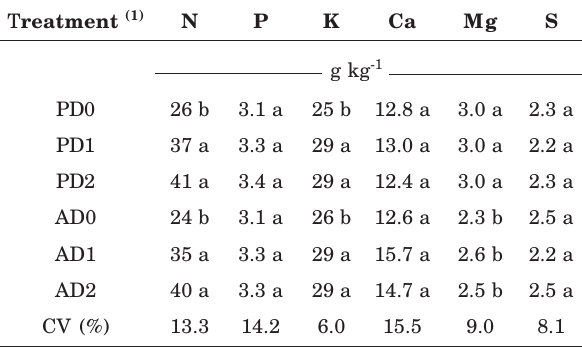
Values followed by same letter in columns, are not significantly different at p 0.05 by the LSD test. (1) PD0: Pérola without NPK fertilization, PD1: Pérola with 50 % of recommended NPK fertilization; PD2: Pérola with 100 % of recommended NPK fertilization; AD0: IAC Alvorada without NPK fertilization, AD1: IAC Alvorada with 50 % of recommended NPK fertilization; AD2: IAC Alvorada with 100 % of recommended NPK